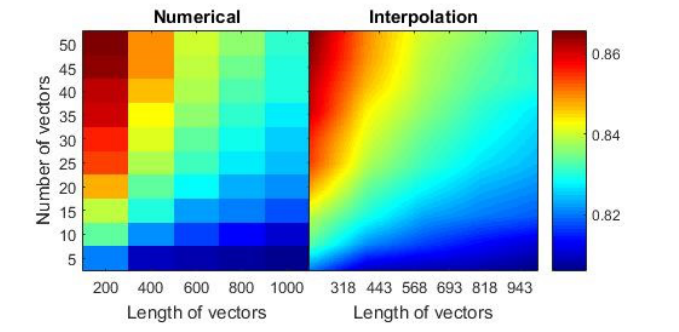
Figure 6. Numerical search for the largest overlap following the method described in equa- tion